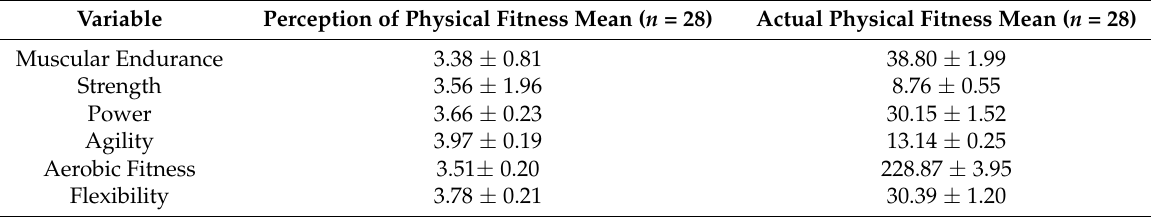
Table 2. Perception of Physical Fitness and Measured Physical Fitness Outcomes of Latina and Black Children (Mean ±